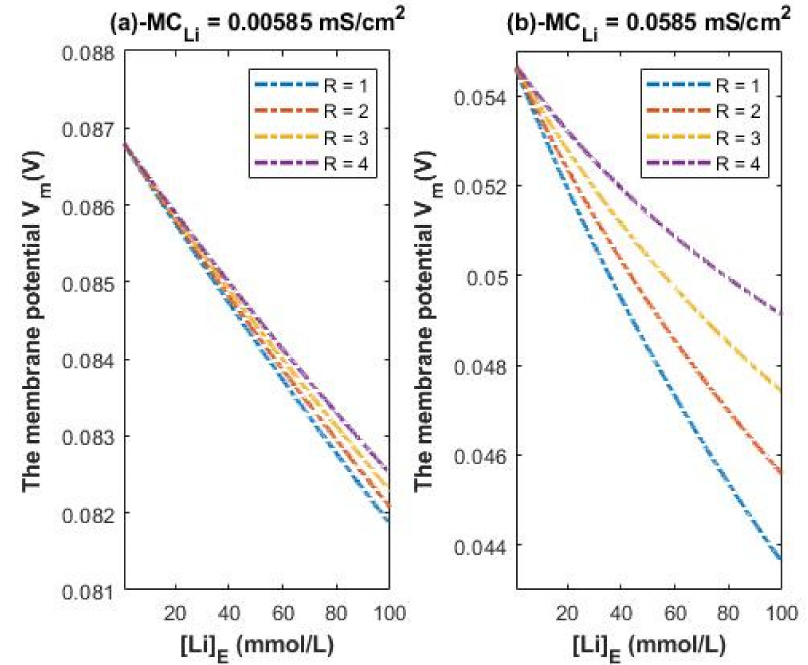
Figure 9. The figure represents the influence of classical transport of lithium ions on the resting membrane potential according to the concentration range 1–100 mmol/L for extracellular lithium ions. In this evaluation, the membrane conductance values in the previous figure (0.005 and 0.05) are increased by a factor of 1.17, which is the acceleration ratio between Li-6 and Li-7. ( a ) The influence on the resting membrane potential is evaluated when the membrane conductance of lithium ions Li-6 is 0.00585 mS/cm 2 , which is increased by 1.17 while the membrane conductance of sodium ions is still 0.005 mS/cm 2 . ( b ) The influence on the resting membrane potential is evaluated when the membrane conductance of lithium ions Li-6 is 0.0585 mS/cm 2 , which is increased by 1.17 while the membrane conductance of sodium ions is 0.05 mS/cm 2